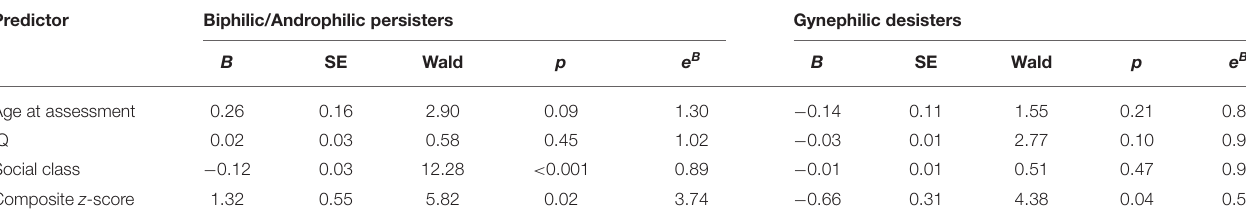
TABLE 5 | Multinomial logistic regression predicting group outcome at follow-up.